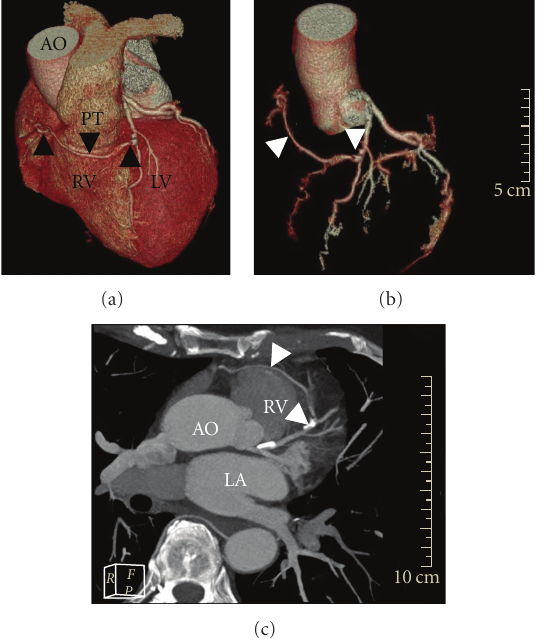
Figure 2: With coronary computed tomography, the presence of an anomalous RCA originating from the mid-LAD and coursing ante- rior of the aorta and the pulmonary trunk could be unambiguously illustrated. Volume rendering acquisitions (a)-(b) and multiplanar reconstructions (c) demonstrate the exact anatomical course of the anomalous vessel (black arrowheads in (a) and white arrowheads in (b) & (c)). (a) Overview of coronary vessel course in relation to the great arterial vessels aorta and pulmonary trunk; (b) coronary Tree; (c) axial maximum intensity projection. Ao indicates Aorta; LA: left atrium, RV: right ventricle, and PT: pulmonary